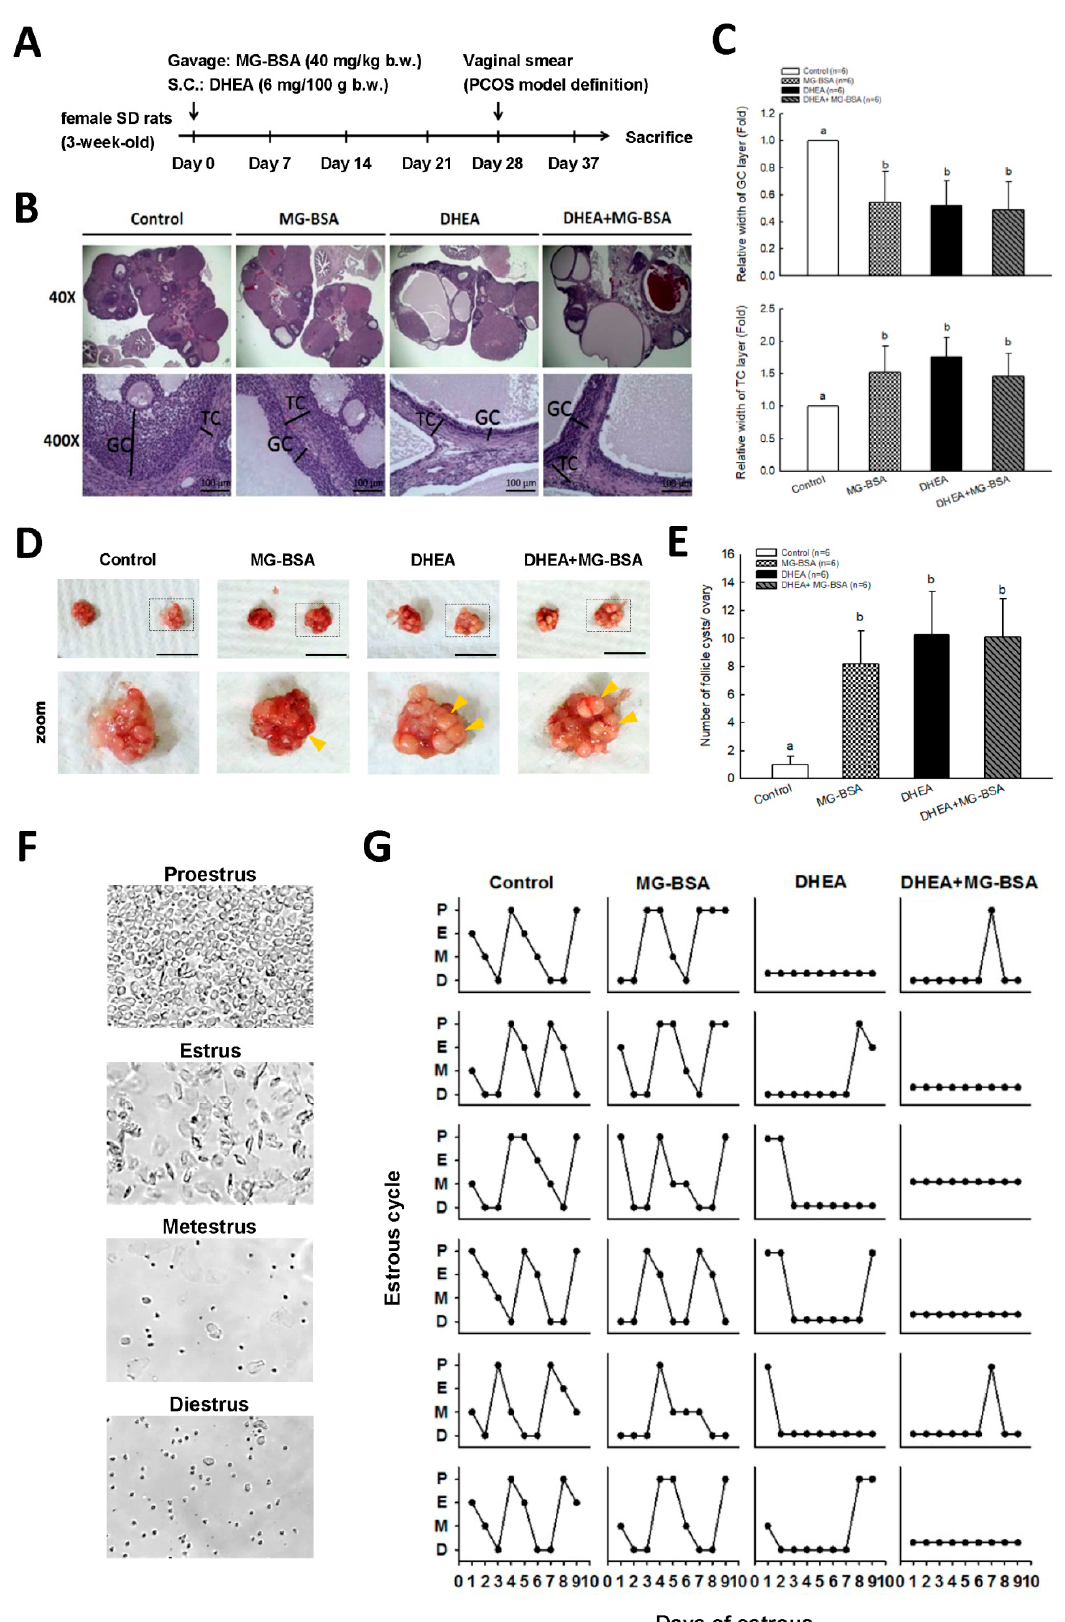
Figure 5. E ff ects of dietary MG-BSA on DHEA-induced PCOS rats. ( A ) Graphical depiction of the PCOS model via DHEA induction and daily MG-BSA treatment. After treatment for four weeks, the estrous cycle was monitored by vaginal smears for an additional nine days. ( B ) Ovarian sections